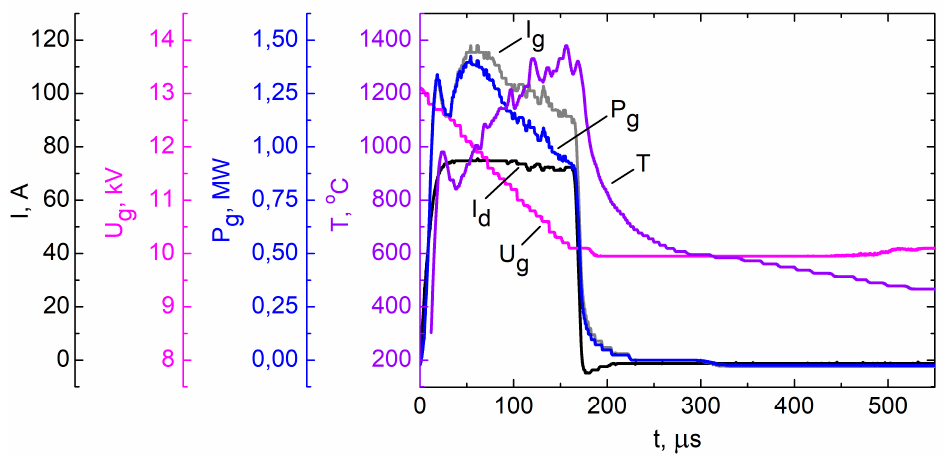
Figure 4. Waveforms of the plasma cathode discharge current I d , current in the acceleration gap, I g , accelerating voltage U g , and surface temperature T , and time variations of the pulse power in the acceleration gap circuit, P g for the sample with a 1- μ m coating.